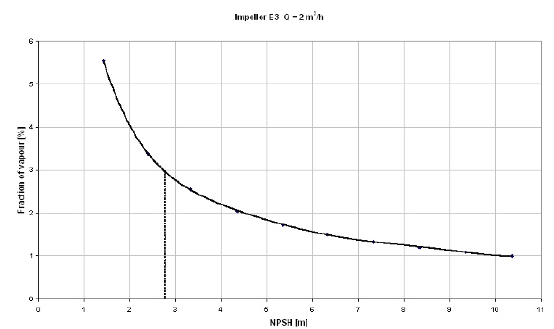
Figure 6. Numerical mesh presented on whole impeller E3.